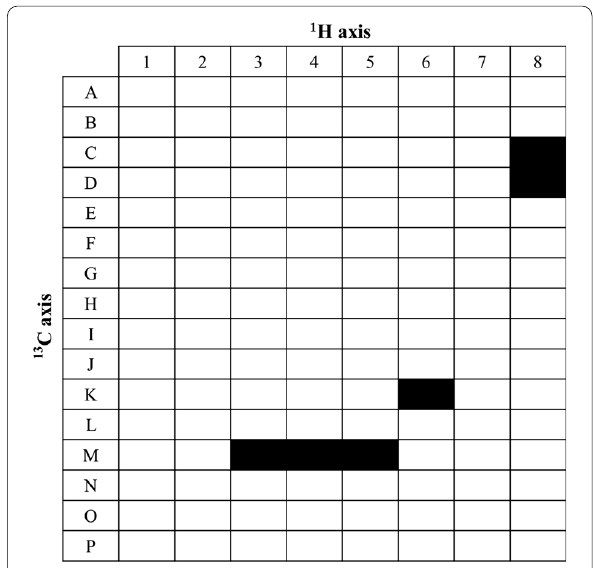
Fig. 4 Cross‑peaks region of Pinaceae exudate in HSQC spectrum